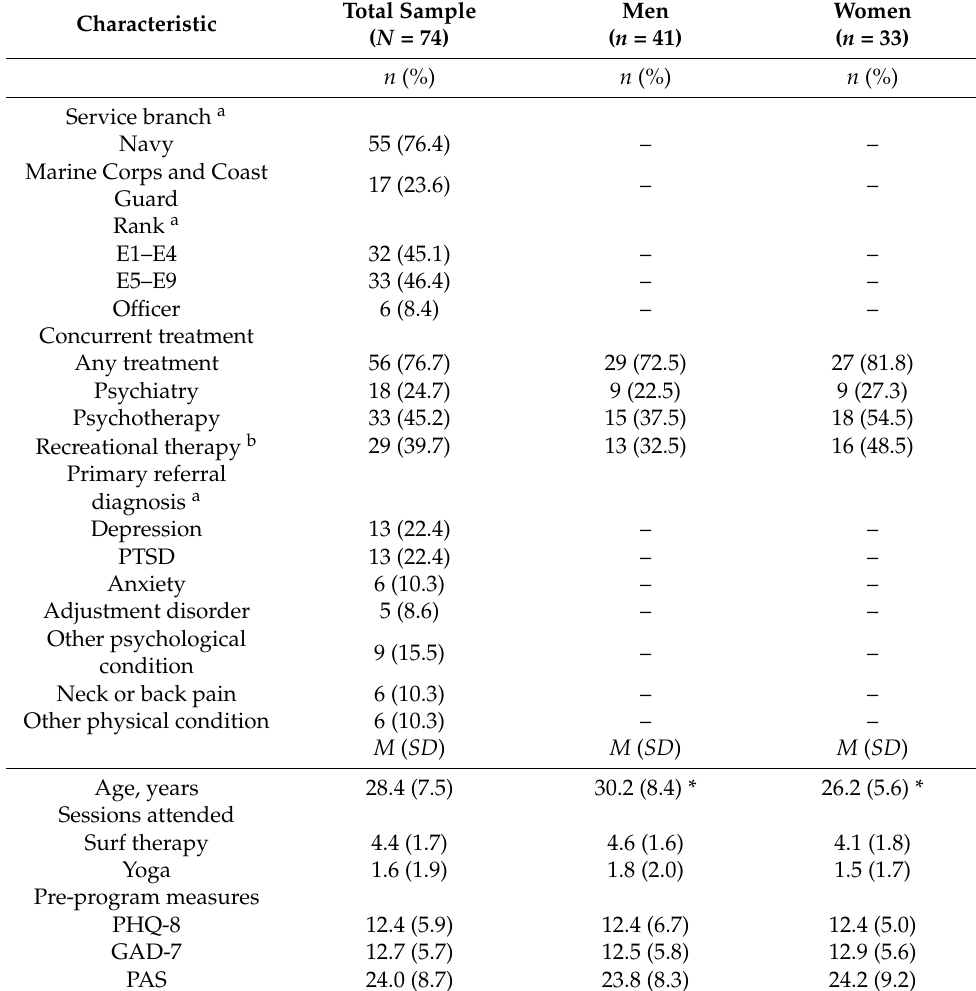
Table 1. Pre-program sample